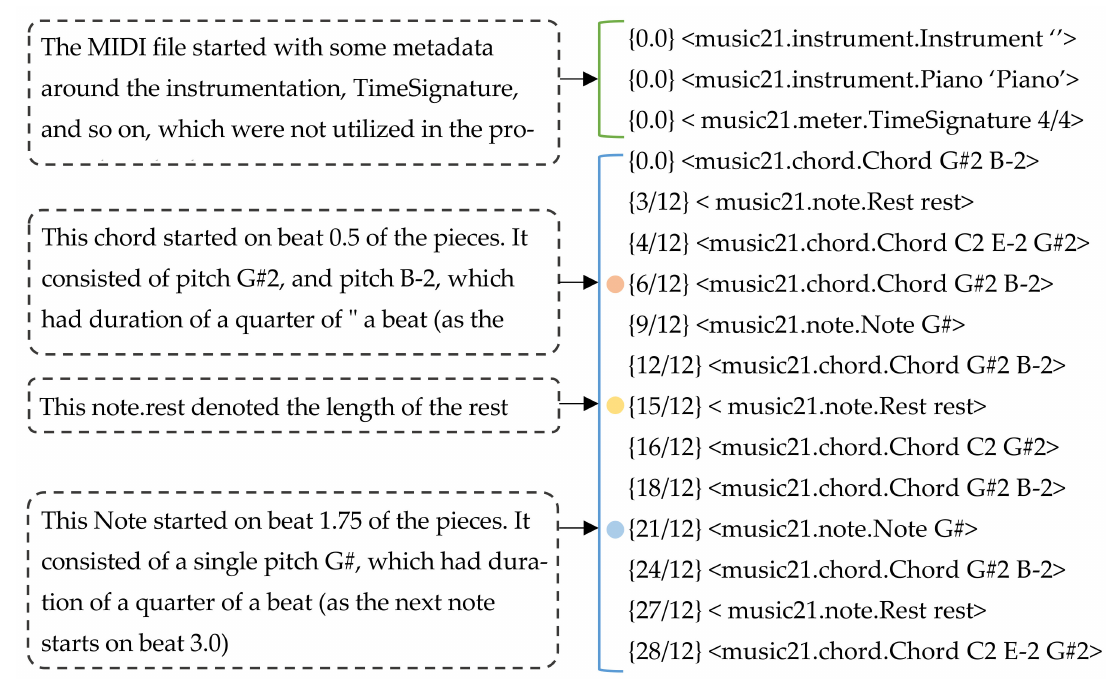
Figure 2. Symbolic musical information of MIDI.